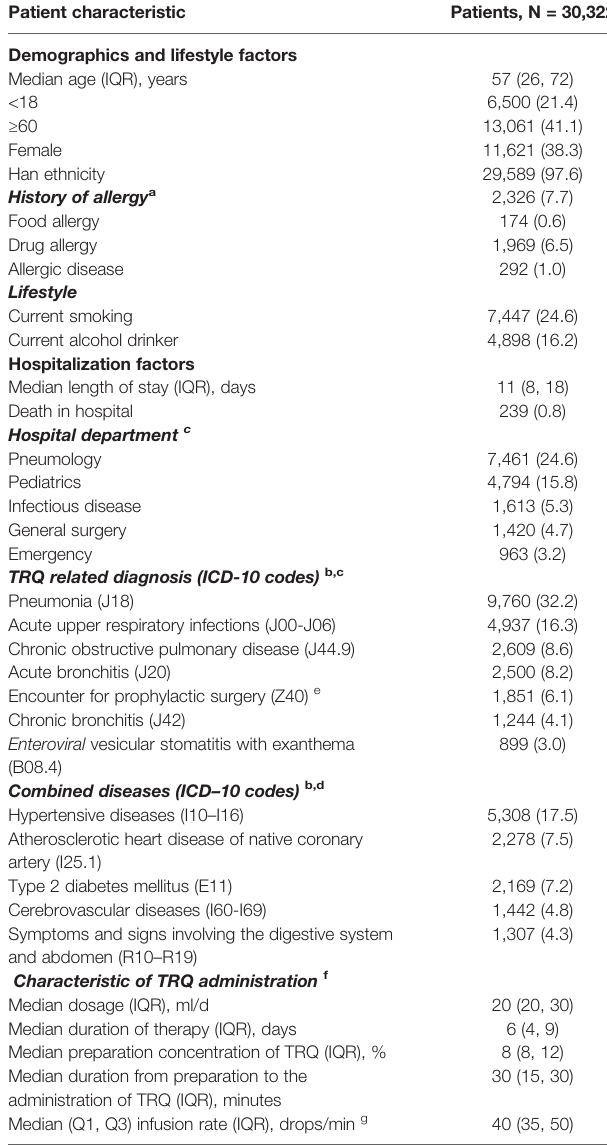
TABLE 1 | Baseline characteristics of the study population. Data are n (%) unless otherwise stated. Patient characteristic Patients, N =